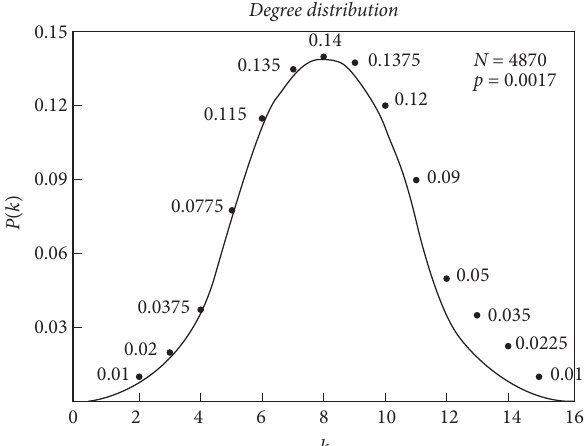
Figure 10: Degree distribution of the model.